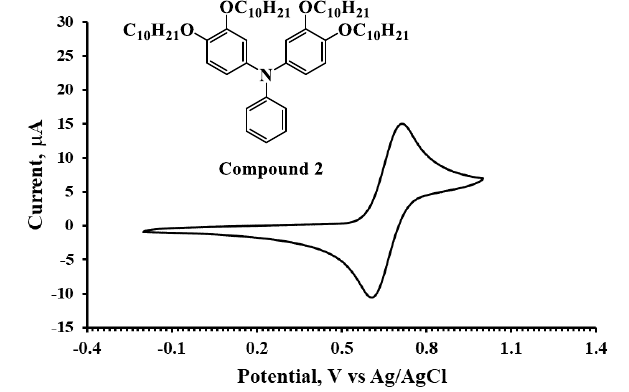
Figure 2. Cyclic voltammogram of Compound 1 in DCM solution (10 − 3 M).